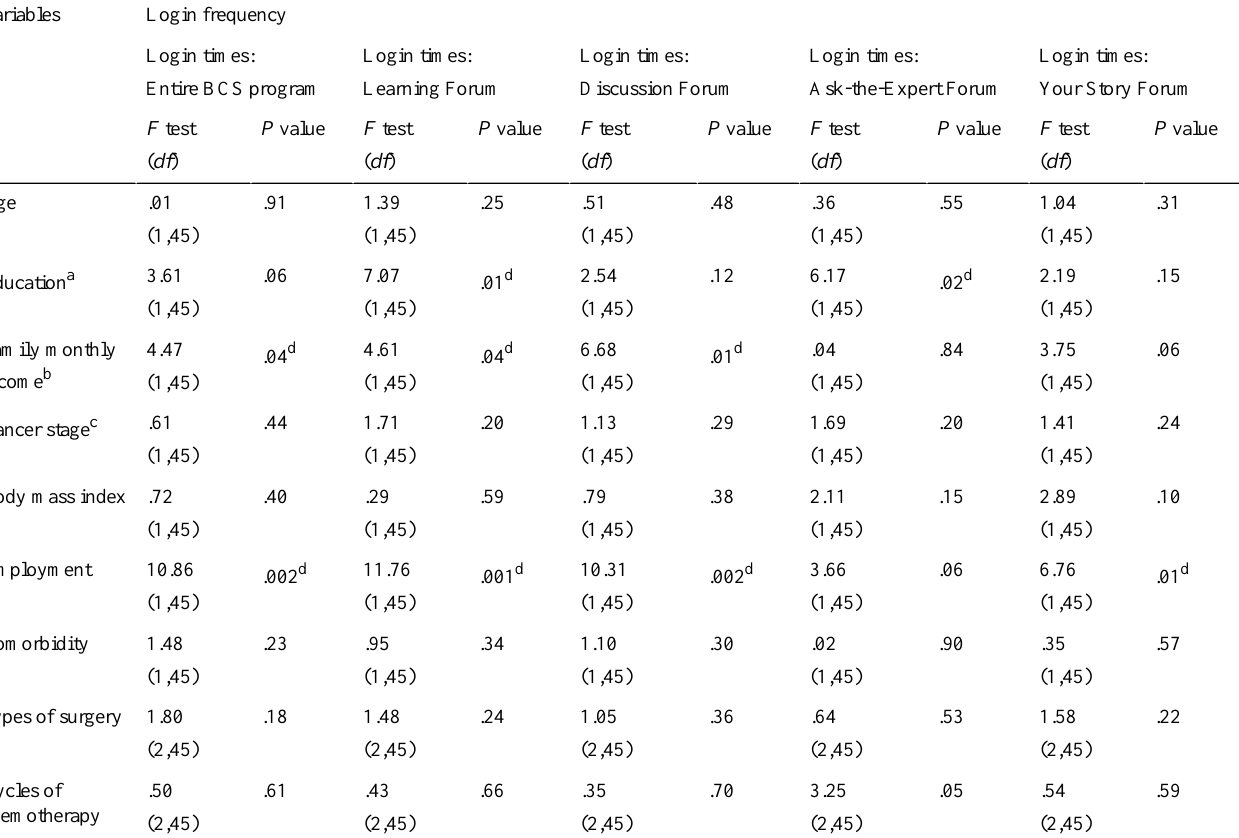
Table 3. Associations between login frequency in Breast Cancer eSupport program and demographic and clinical characteristics (n=57). Login